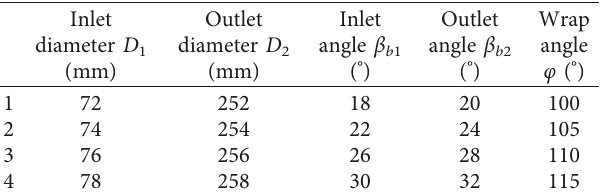
Table 11: Controllable factors and their